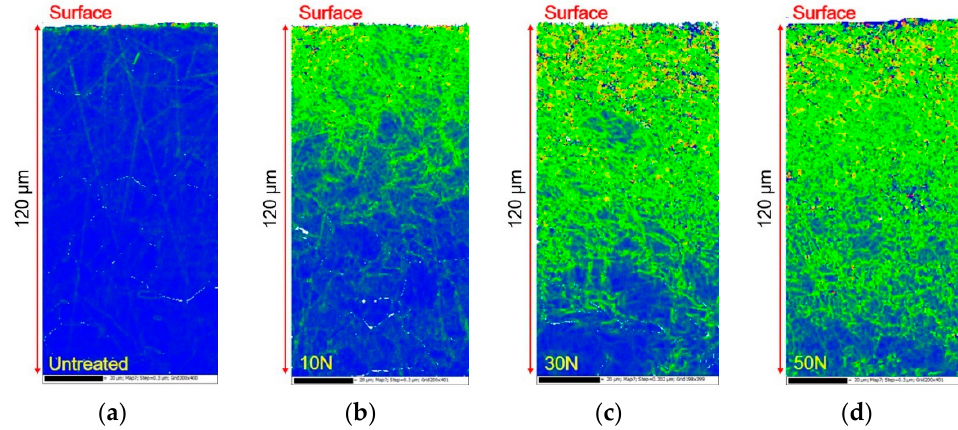
Figure 7. The effect of the static load in UNSM treatment on the dislocation density of Alloy 600 by kernel average misorientation; ( a ) untreated; ( b ) 10 N; ( c ) 30 N; ( d ) 50 N.